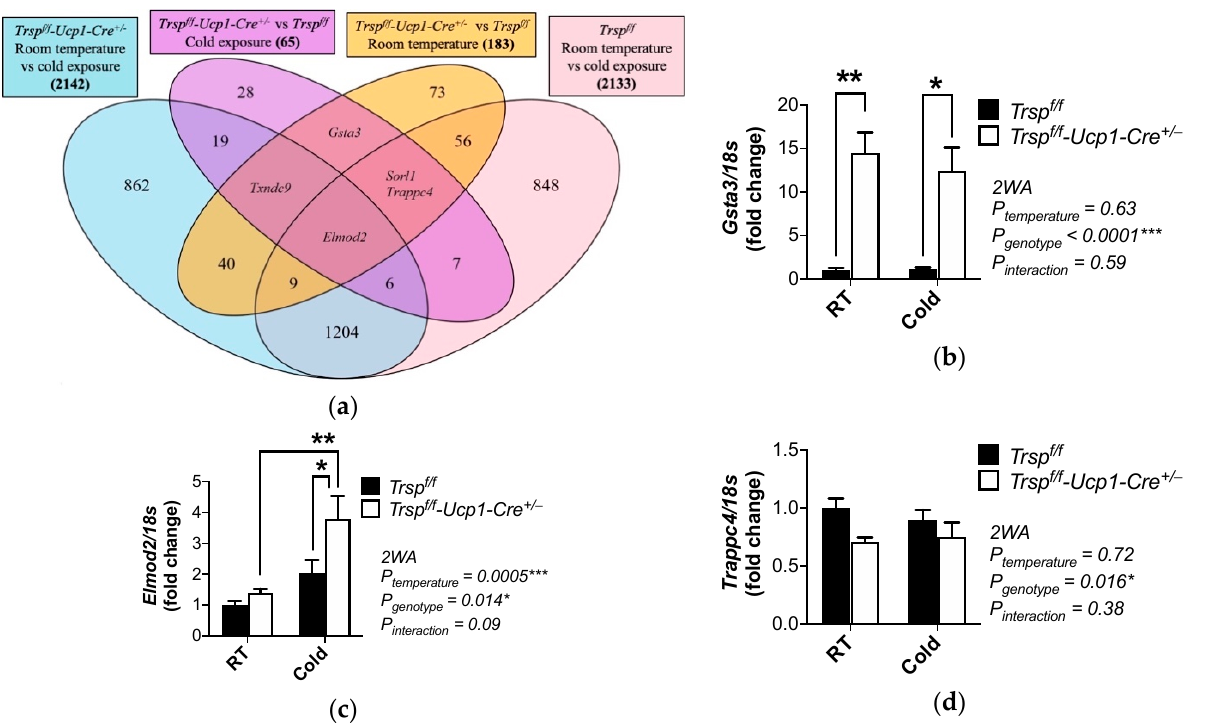
Figure 7. Gene expression changes in Trsp f/f -Ucp1-Cre +/ − mice at room temperature and after acute cold exposure. ( a ) Venn diagram of microarray data sets, showing the number of genes differentially expressed between Trsp f/f -Ucp1-Cre +/ − and Trsp f/f mice at room temperature and after cold exposure. ( b – d ) Validation of microarray results by qPCR analysis of the expression of Gsta3 , Elmod2 and Trappc4 , respectively. Data are mean ± SD. p -values are shown in graphs and were calculated by two-way ANOVA (2WA) followed by Bonferroni’s post test analysis. * p < 0.05,** p < 0.01, and *** p < 0.001. RT, room